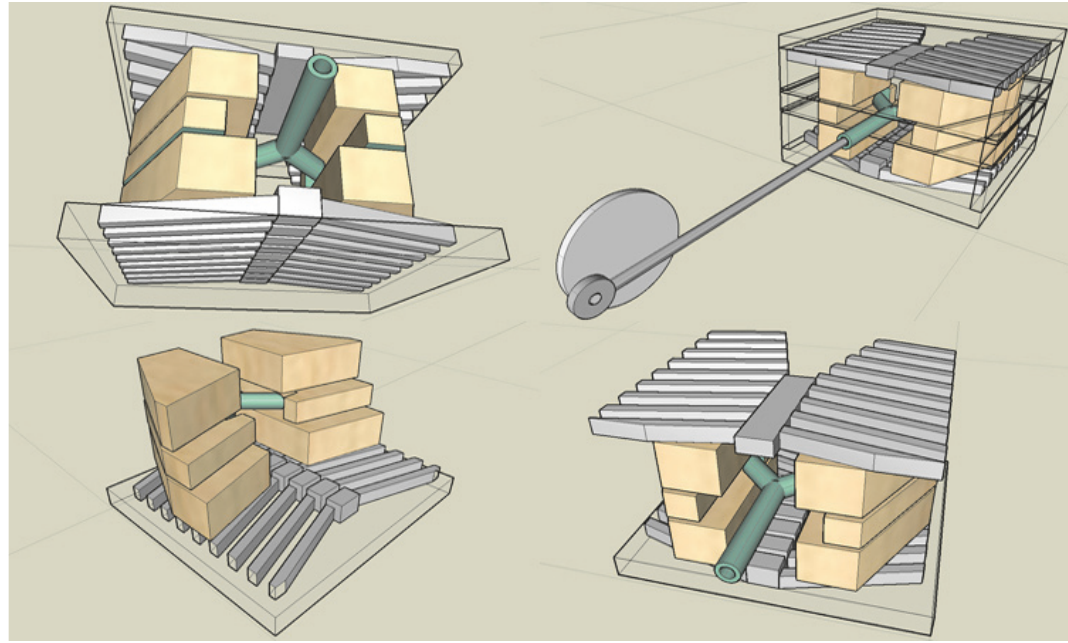
Figure 2: Rendering of phantom design and components. 3D perspective view of renderings of the second phantom, using FORMZ CAD software, showing different parts of the phantom without the SE. Notice the gradual stepped contour of the inferior part of the 6-plated lung in the lower left